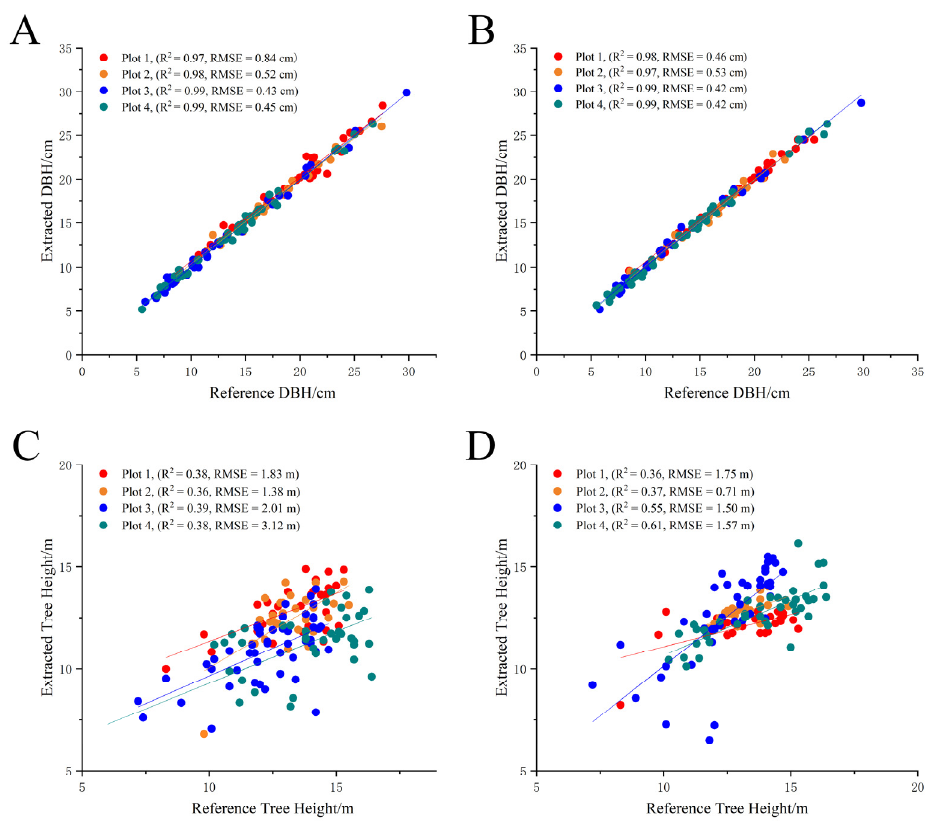
Figure 7. Comparison of DBH ( A ) and tree height ( C ) extracted by backpack LiDAR with measured data, and comparison of DBH ( B ) and tree height ( D ) extracted from TLS data with measured data (four colors indicate each of the four sample plots).